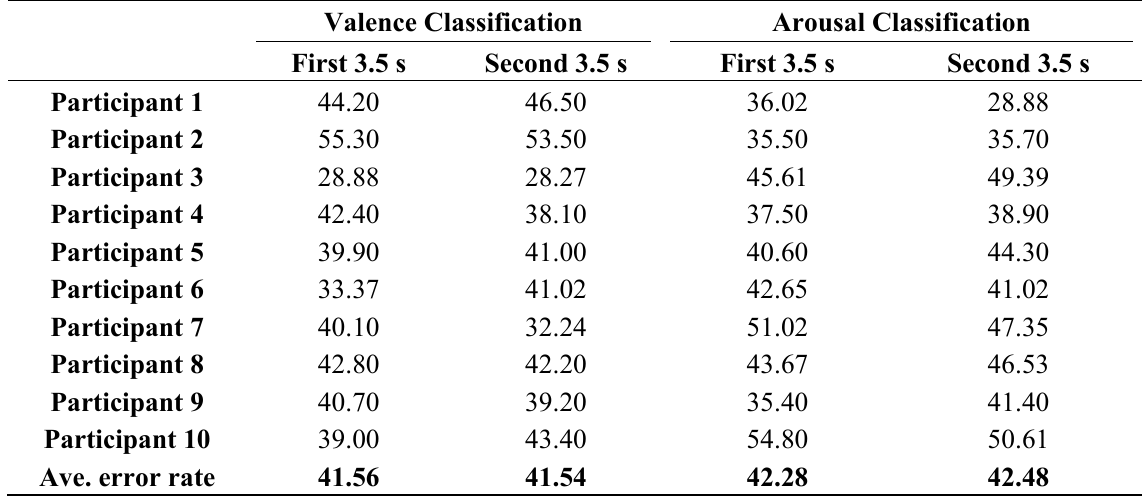
Table 4. Average error rates of 10 participants for the first and second 3.5-s EEG intervals (%) using SP feature and k -NN